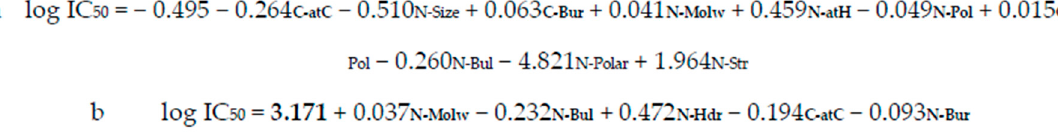
Figure 1. FR ( a ) and BR ( b ) equations explaining the structure–function of the ACE-inhibiting/bitter dipeptides (statistically significant parameters are indicated in